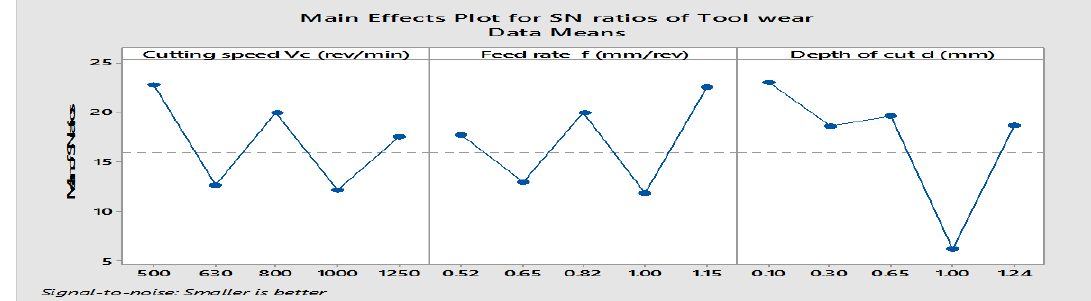
Figure 9: Main effect plot of S/N ratio for tool wear using